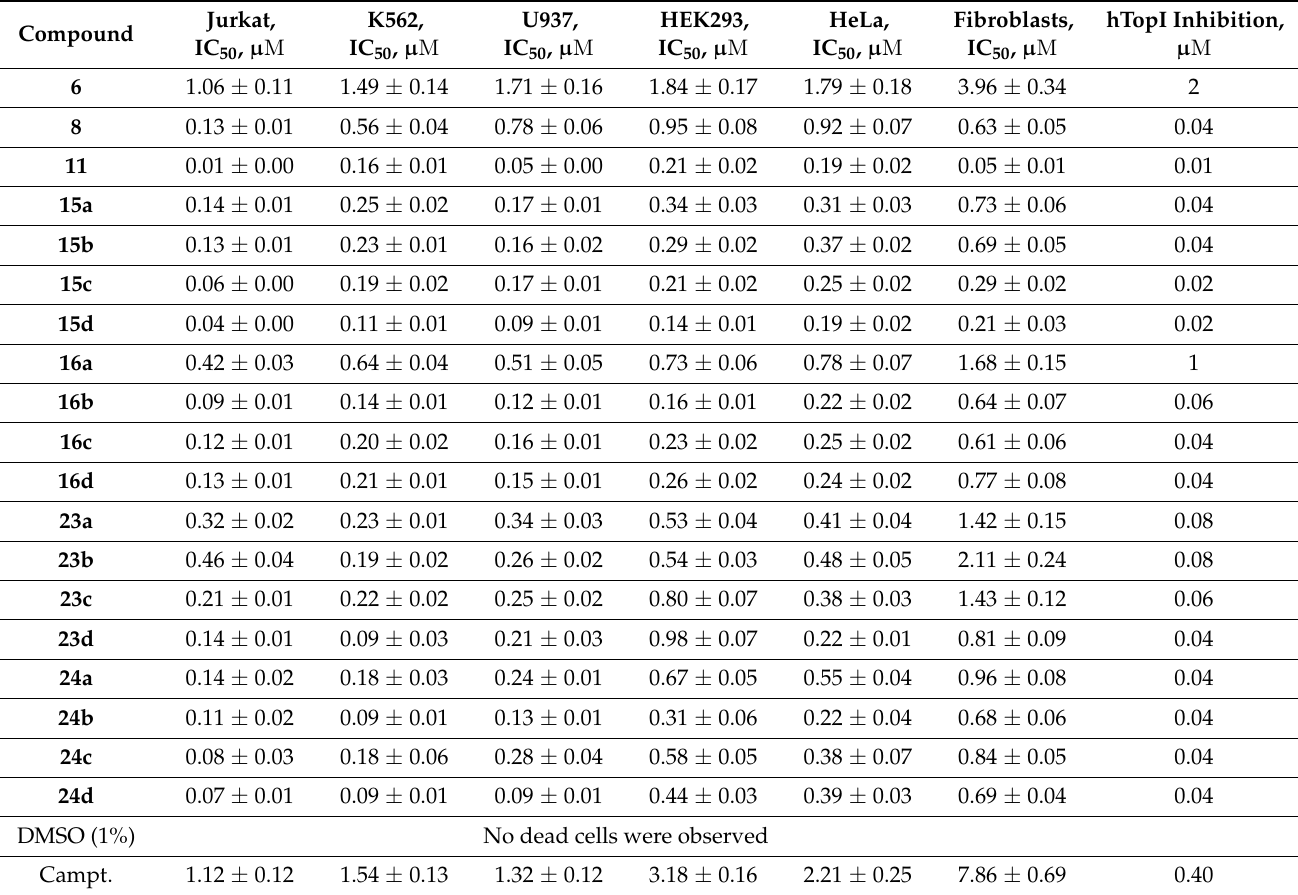
Table 1. Cytotoxic activity of compounds 8 , 11 , 15a – d , 16a – d , 23a – d , and 24a – d (48